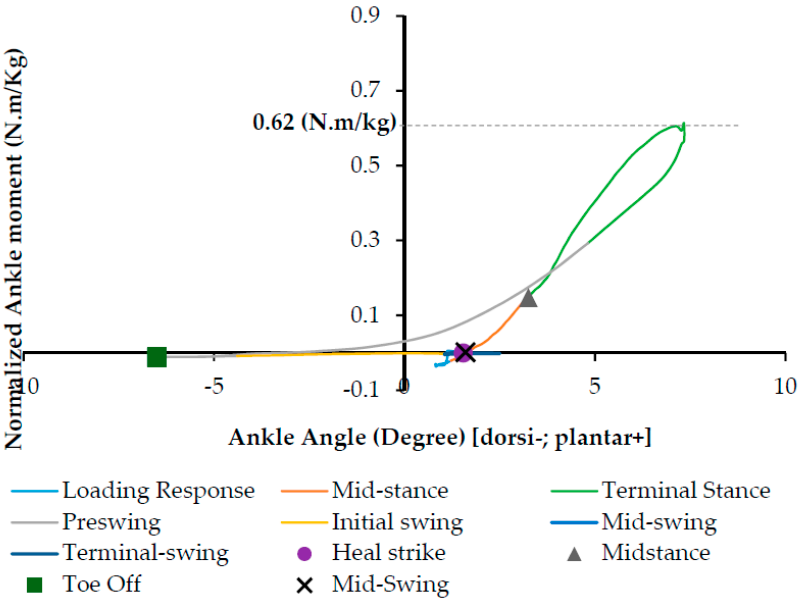
Figure 10. Ankle torque-angle loop for a healthy subject during normal walking.